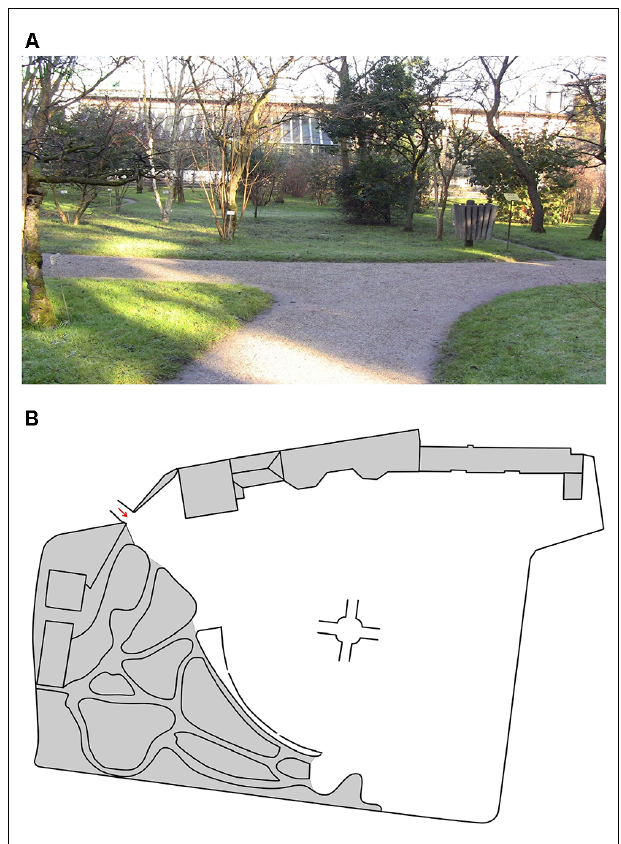
FIGURE 1 | Example of the route repetition task (A) , and the sketch used in the sketch map task (B) .